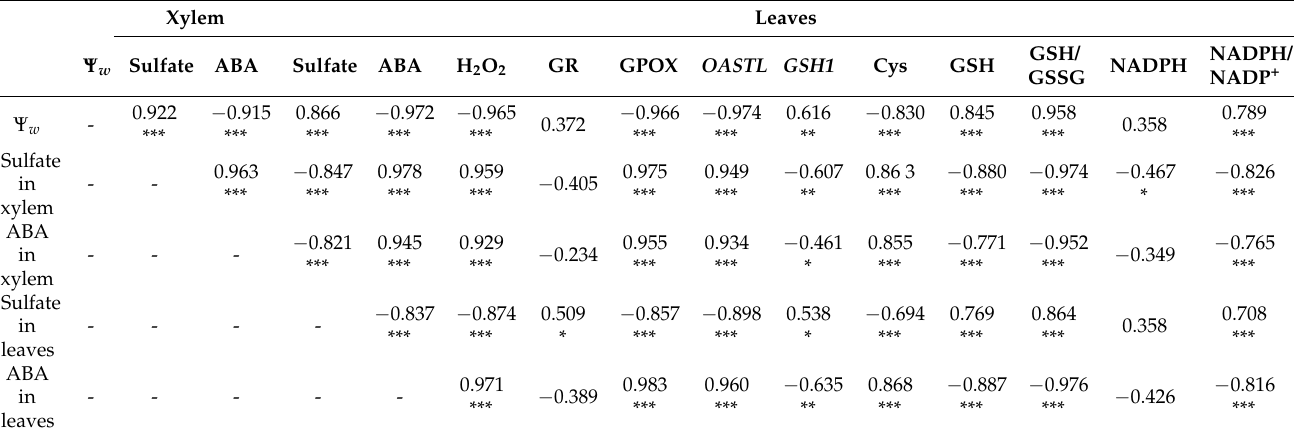
Table 3. Linear correlations of sulfate and ABA with the descriptive parameters of H 2 O 2 production and scavenging, sulfur assimilation and redox status as affected by drought stress for 14